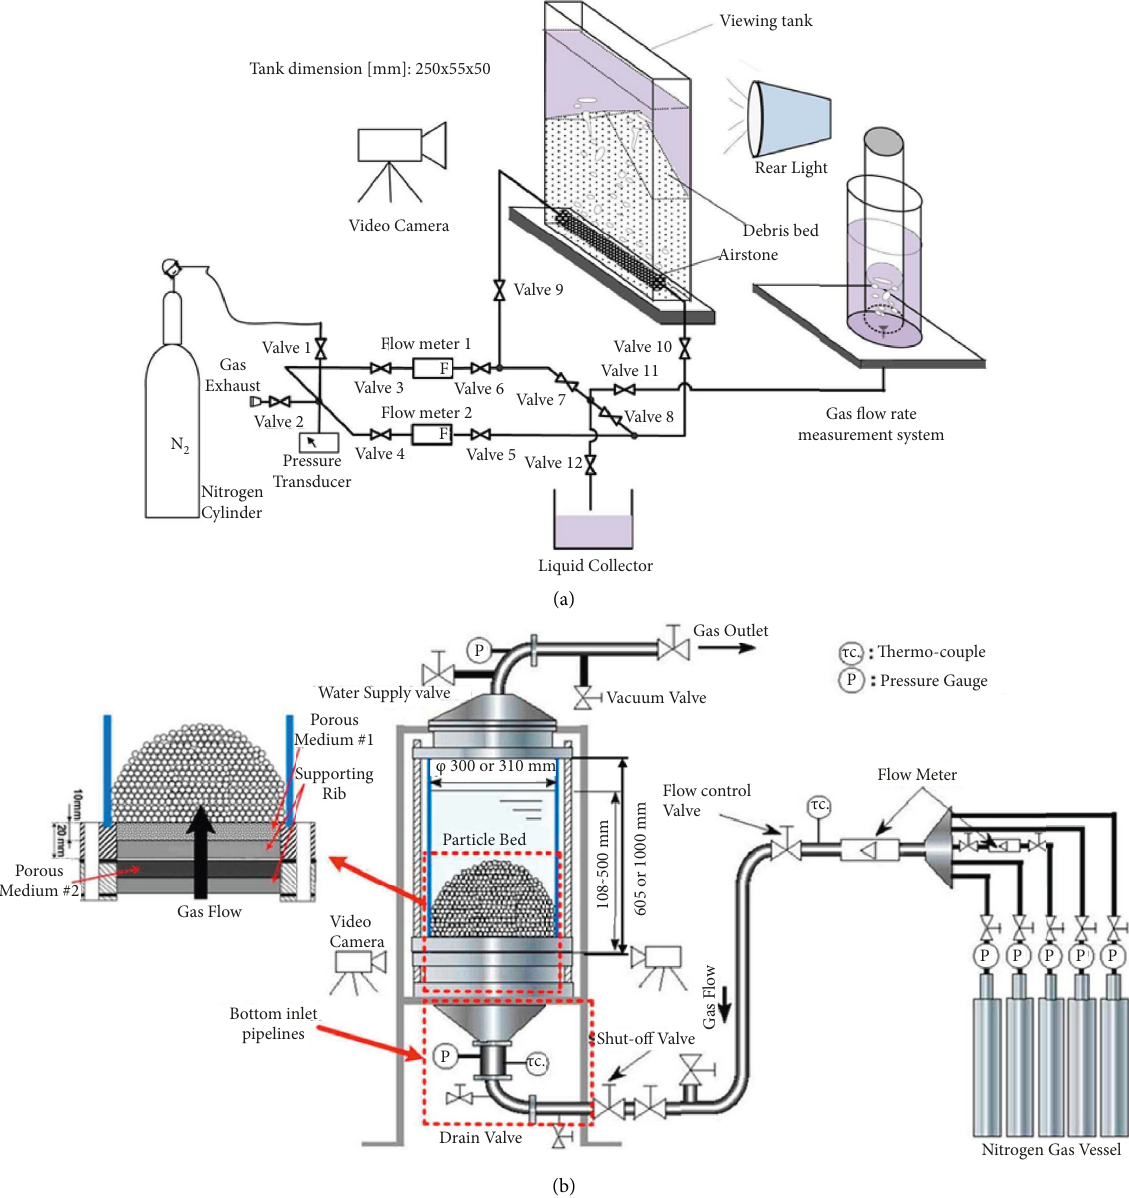
Figure 9: Schematic view of self-leveling experimental systems using gas-injection method [32, 36] (a) 2D system (b) 3D